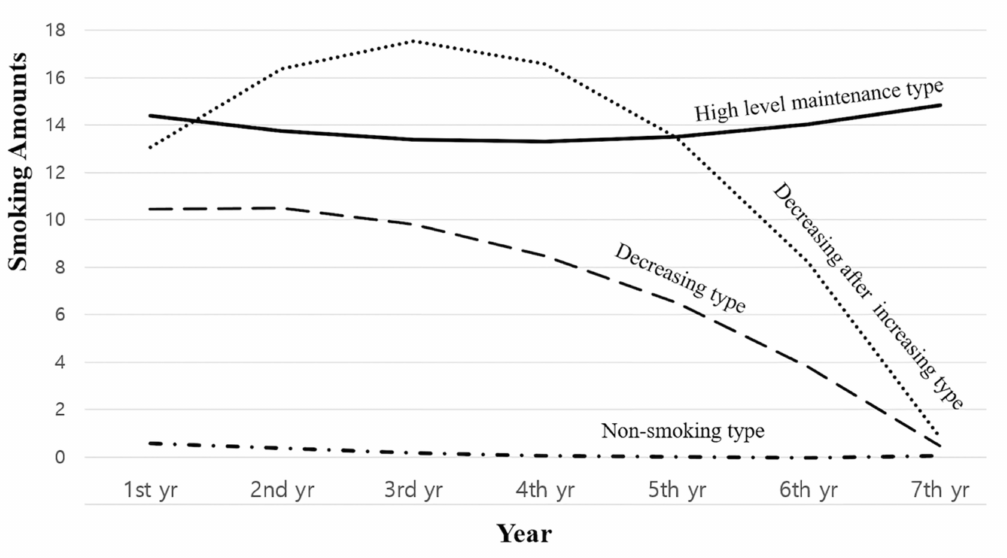
Figure 1. Estimation of smoking behavior change patterns in the older adults.